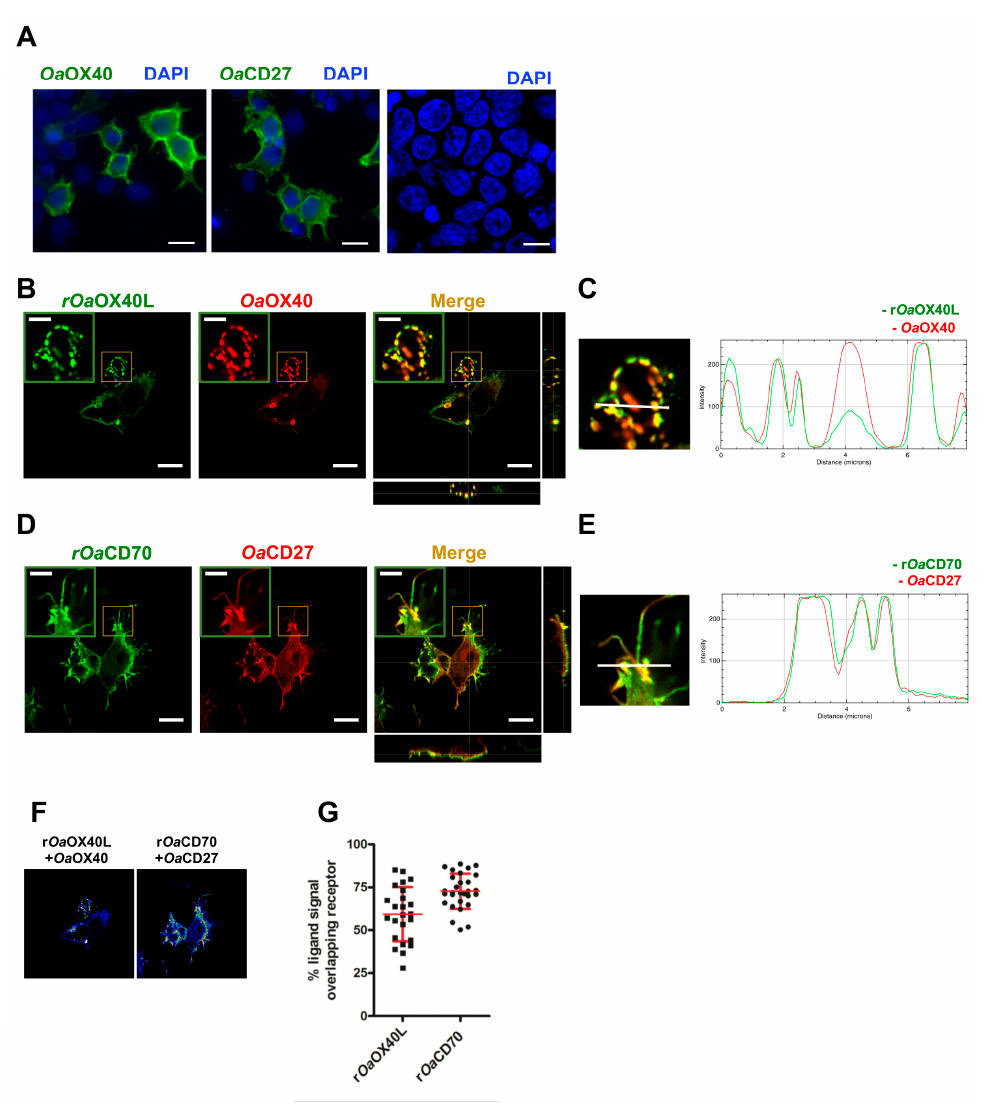
Figure 2. Colocalisation of the ovine OX40L and CD70 ligands with their cognate receptors. ( A ) Immunolocalisation of Oa OX40 and Oa CD27 in transfected HEK293 cells detected by anti-V5 tag antibody and counterstained with DAPI. Cells expressing ( B ) Oa OX40 or ( D ) Oa CD27, were incubated with 10 μ g of ( B ) purified r Oa OX40L or ( D ) purified r Oa CD70 for 15 min before fixation and immunofluorescence. Oa OX40 and Oa CD27 expression was detected using anti-V5 tag antibodies (red); r Oa OX40L and r Oa CD70 presence were detected with an anti-ovine Fc antibody (green). ( B,D ) Insets show detail of colocalisation in each case. Merge and orthogonal projection were obtained with ImageJ software. Scale bar = 10 μ m, indent scale bar = 4 μ m. In panel ( C ) and ( E ), an enlarged image of corresponding insets in Merge and fluorescence intensity profiles for the indicated white lines on the images are shown. ( F ) ImageJ Image calculator function was used to evaluate colocalisation of ligand signal with its receptor. Representative images of colocalisation analysis in a Z-plane (presented as 16LUT signal) are shown. The ImageJ calculator tool was used for pixel colocalisation for the fluorescence channels of ligands (r Oa OX40L or r Oa CD70) and their respective receptors (r Oa OX40 or r Oa CD27). ( G ) The percentage of recombinant ligand signals colocalising with their receptors in ( F ) was analysed in 25–40 cells for each condition. Mean ± SD are indicated for each